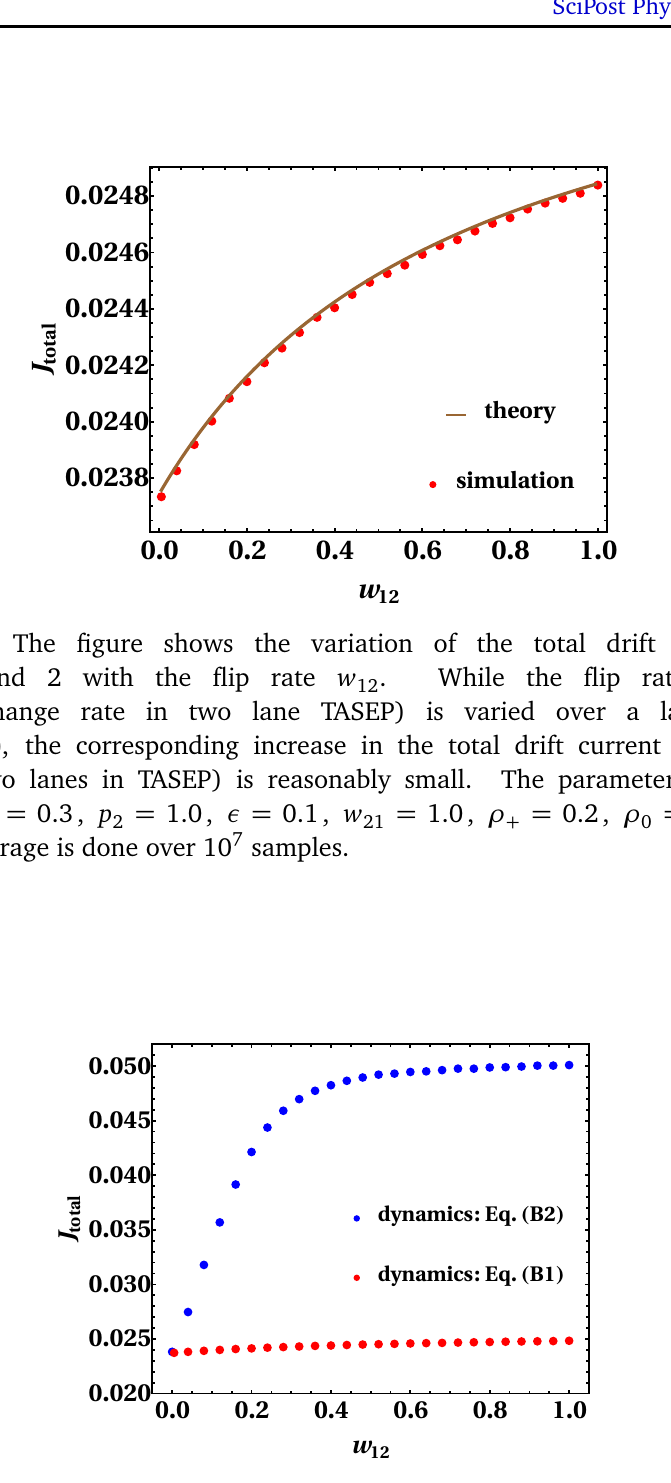
Figure 14: The figure illustrates the comparison of the total drift current J be- total tween the flip process in Eq. (B.1 ) and the proposed variation in Eq. (B.2 ). The current J for the variation Eq. (B.2 ) increases considerably with increasing flip total rate (equivalent lane change rate in two lane TASEP) w , whereas the same for the 12 original flip process Eq. (B.1 ) increase much slowly (Fig. 13). The parameters used = 0.3, p = 1.0, ε = 0.1, w = 1.0, ρ = 0.2, ρ = 0.2. The are L = 10 4 , p + 1 2 21 0 ensemble average is done over 10 7